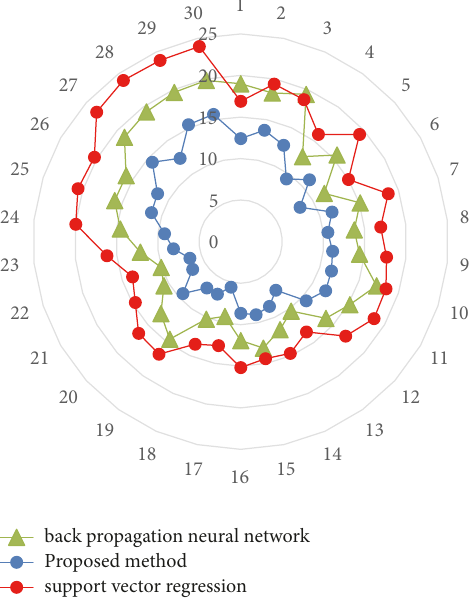
Figure 9: Prediction results of 30 steps for weekday reliability based on different